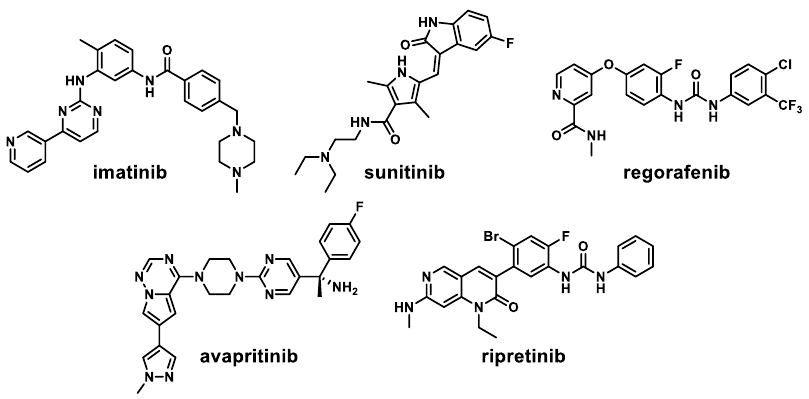
Figure 1. Representative c-KIT inhibitors.